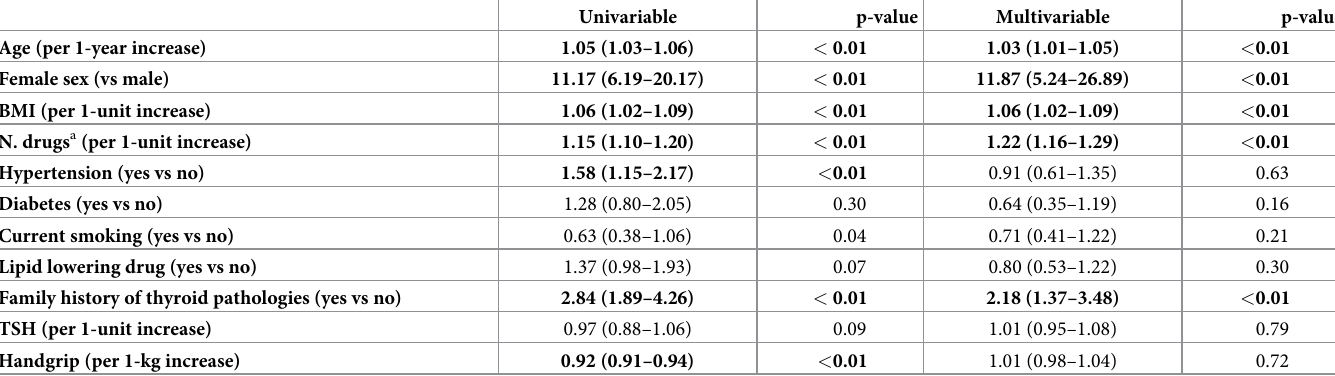
Table 4. Association between chronic levothyroxine use and each factor at a time (logistic regression model).